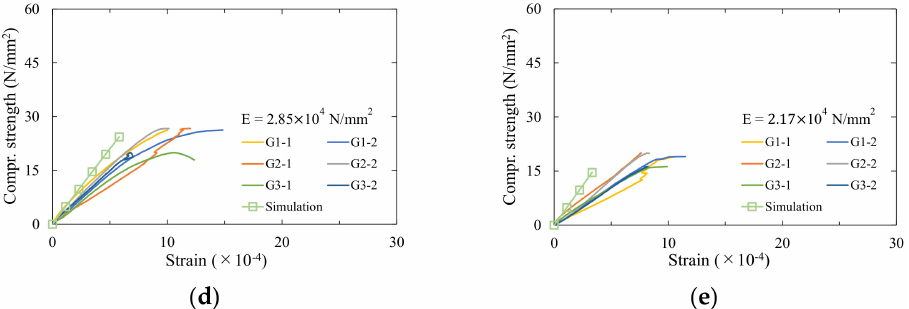
Figure 17. The stress–strain curve of 2008 CS concrete. ( a ) Conventional concrete. ( b ) CS20–75. ( c ) CS20–113. ( d ) CS25–30. ( e ) CS25–45.